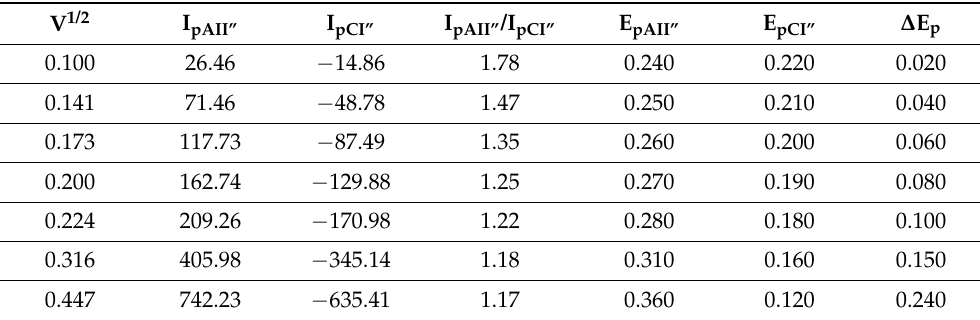
Table 4 for the Fc_CNT paste electrode and in Table 5 for the Zn/Fe_CNT paste electrode. Table 4. Electrochemical data obtained for the Fc/Fc+ redox couple from CVs of the Fc_CNT paste electrode at different scan